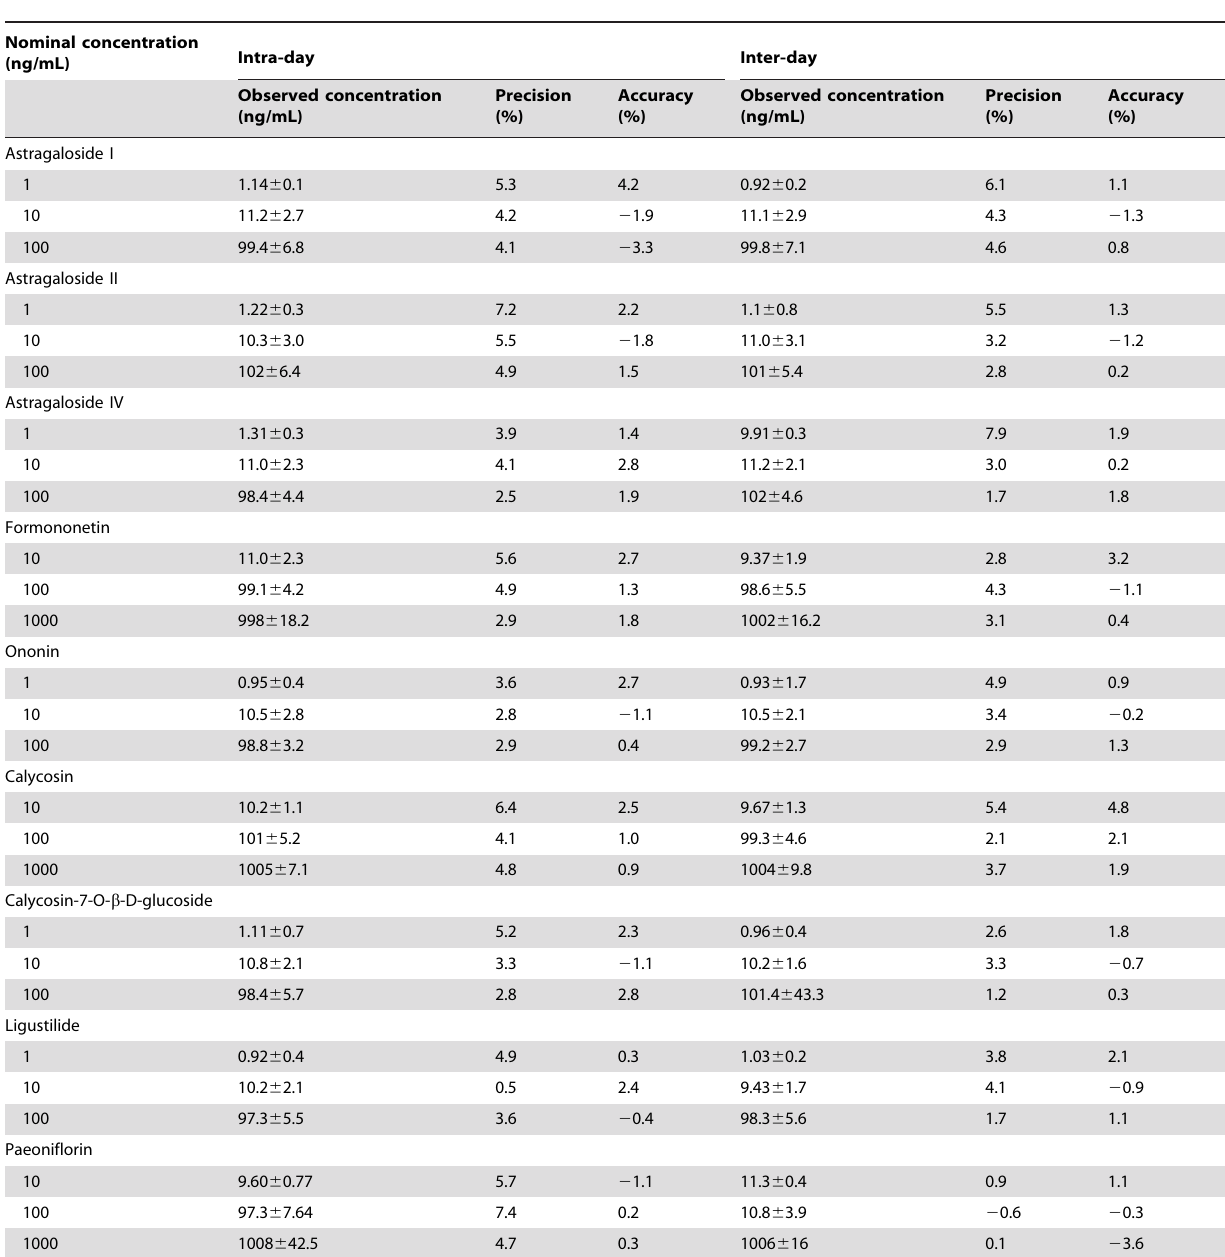
Table 2. Intra-day and inter-day precision and accuracy for the determination for nine compounds from the assay samples (n=